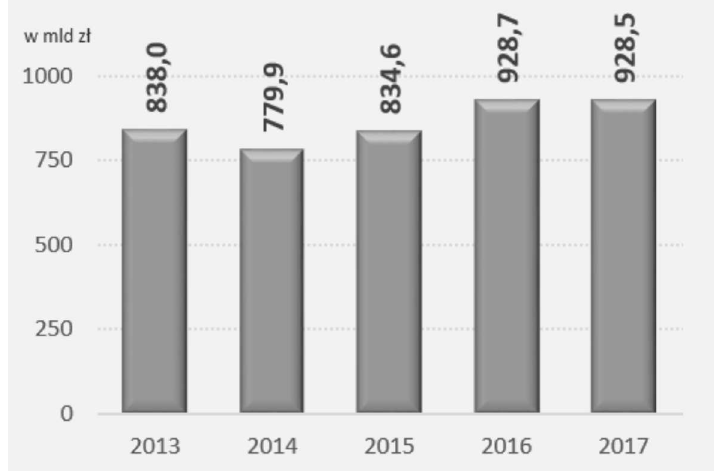
Figure 2. State Treasury debt at year-end 2013–2017